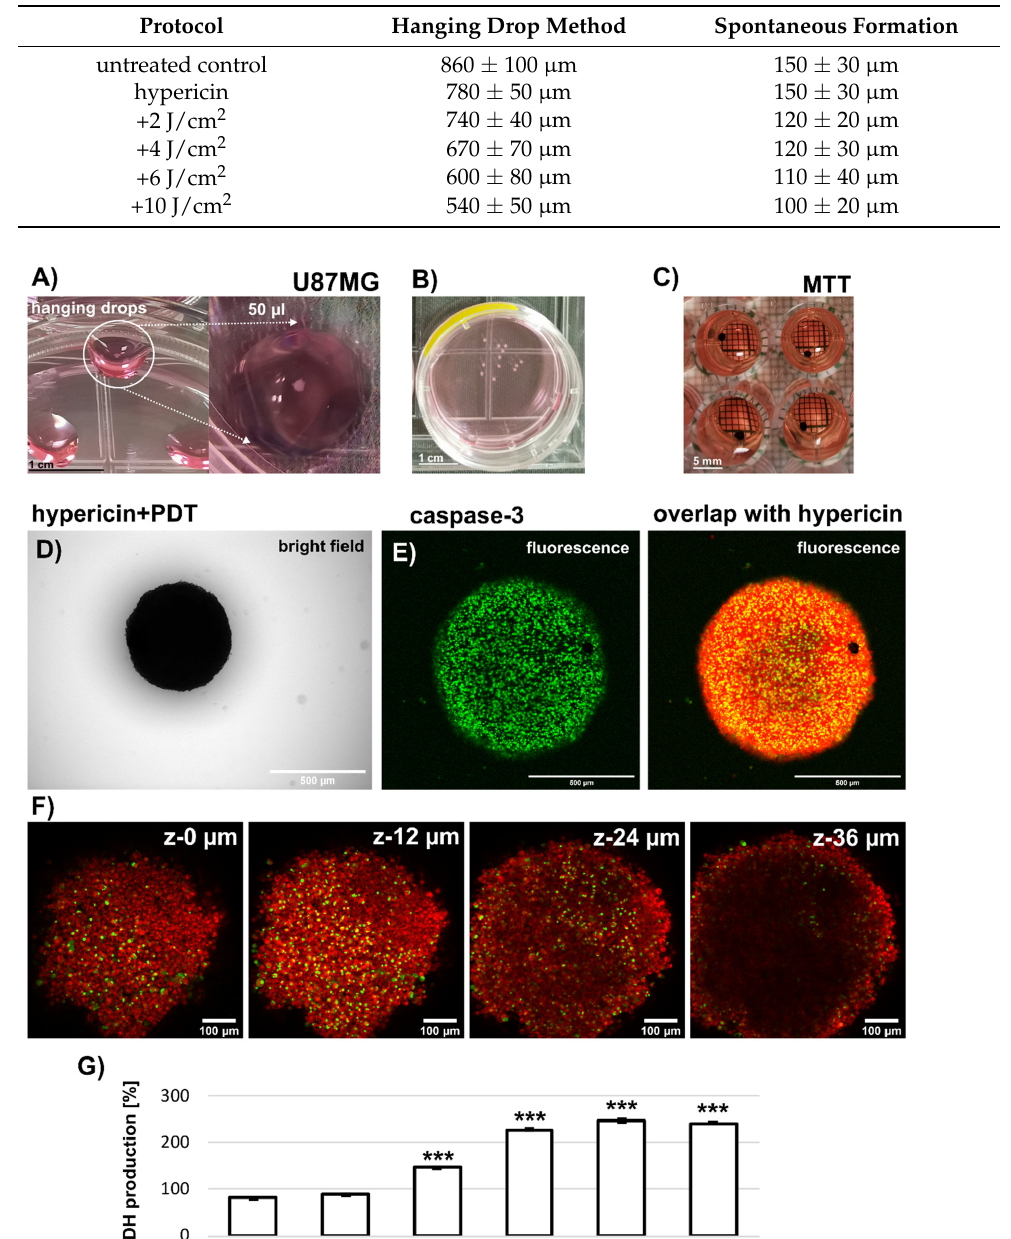
Table 2. Reduction in size of U87MG spheroids observed after hypericin mediated PDT. The values represent the average size values of all spheroids detected (n = 15).